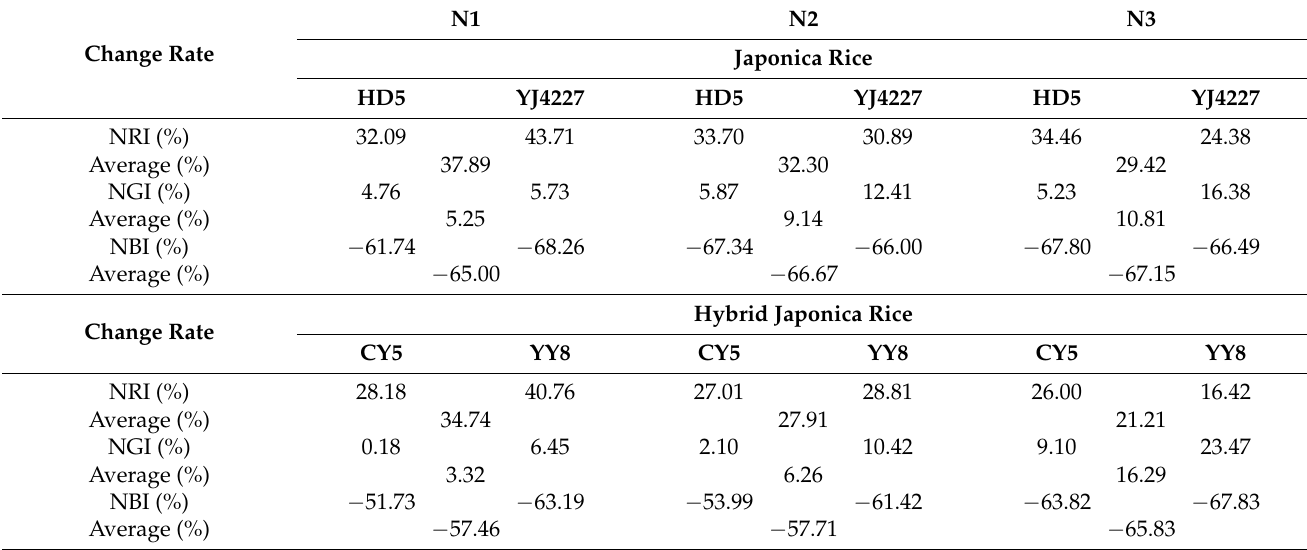
Table 7. Change rates of the standardized value of color for leaves of HD-5, YJ4227, CY-5, and YY-8.